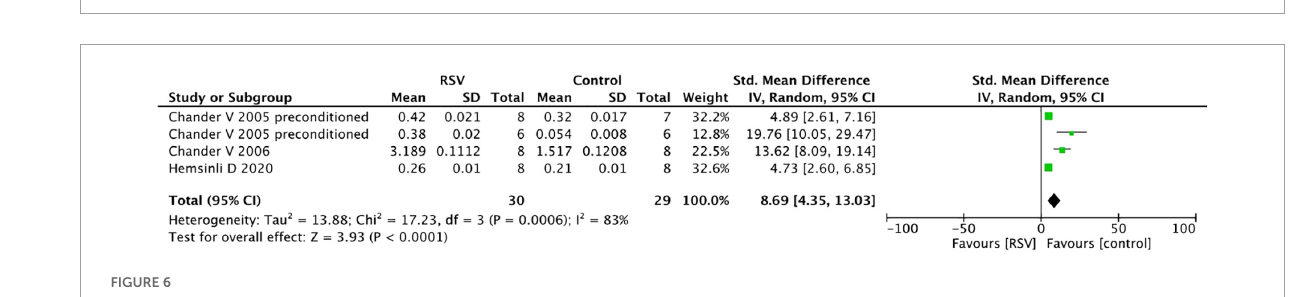
FIGURE6 Forest plot for the effects of resveratrol on catalase.